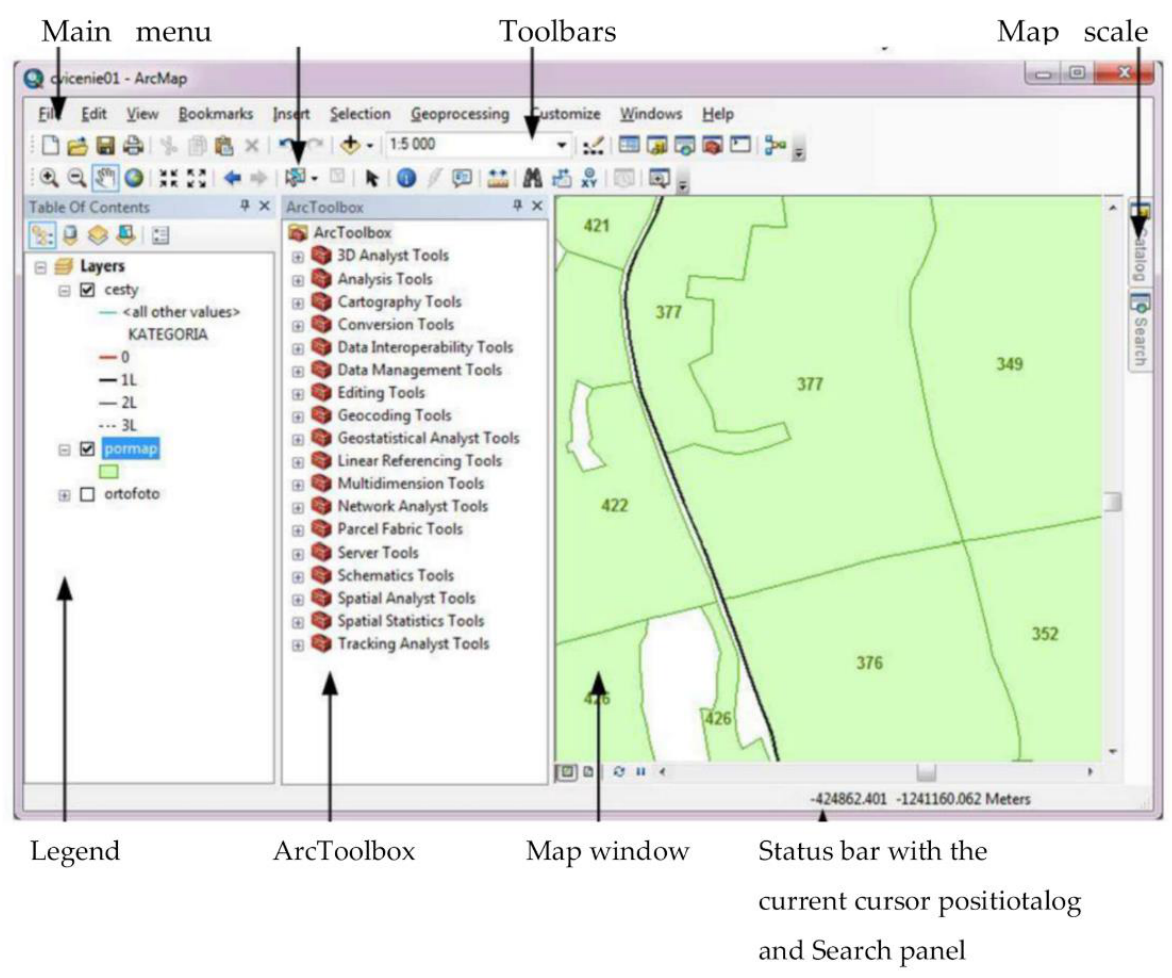
Figure 3. The process of the creation of the algorithm maps, (source: elaborated by authors).